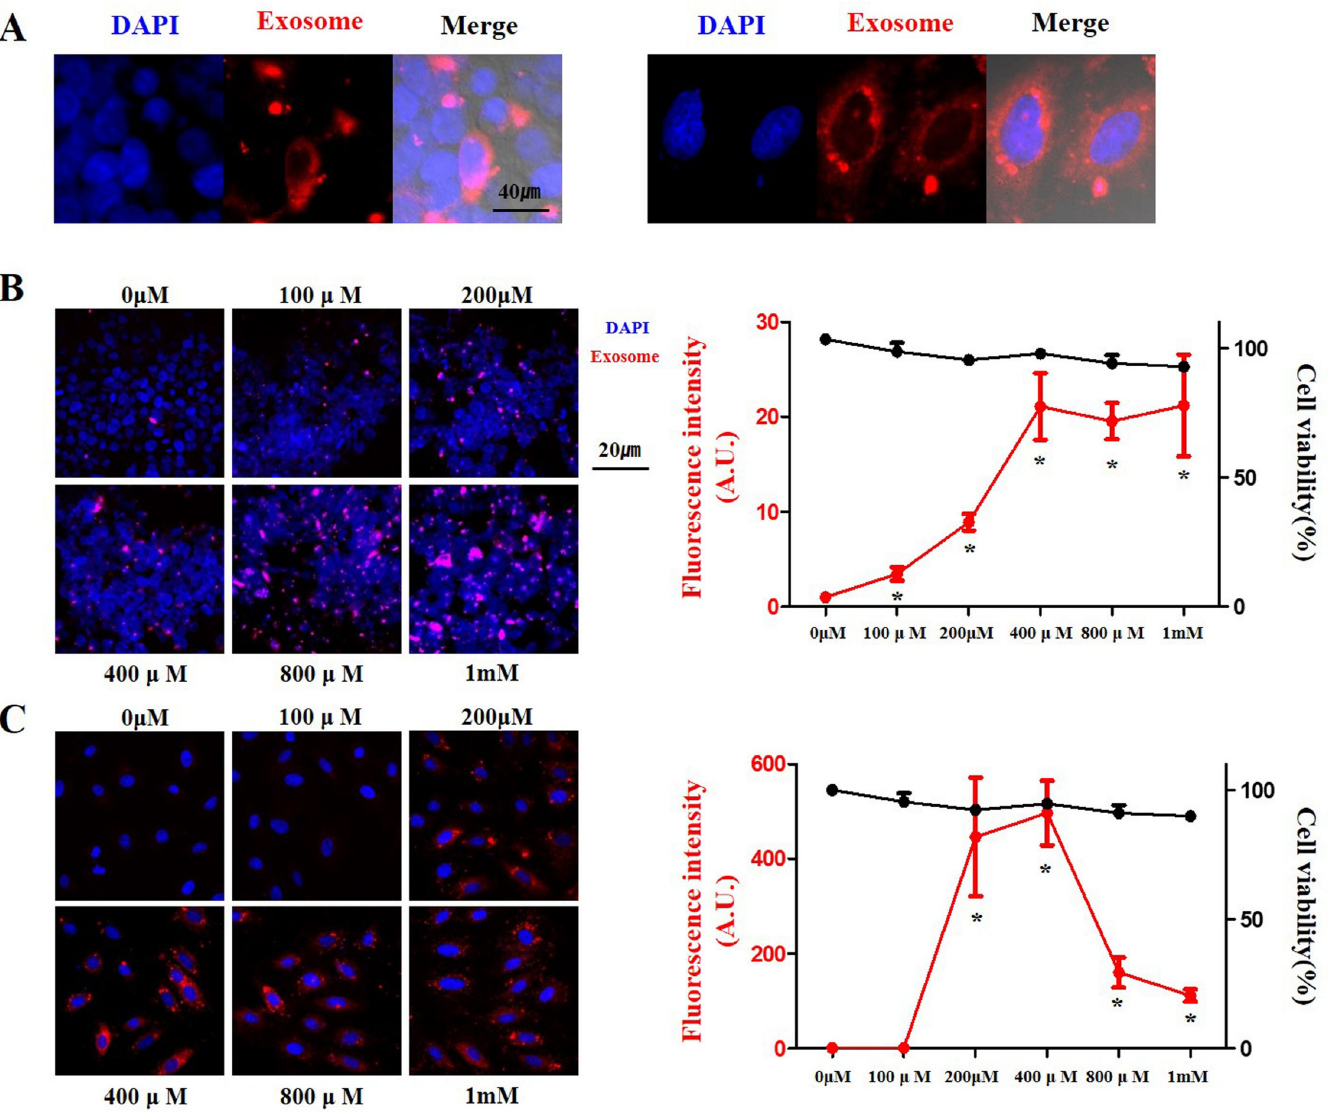
Fig 2. Delivery efficiency of exosomes with CaCl 2 in a dose-dependent manner. (A) Typical example of delivery of exosomes to HEK 293 cells (left panels) and H9C2 cells (right panels). (B) and (C) Delivery efficiency and cell viability of exosomes labeled with PKH26 (red) at different concentrations of CaCl 2 in HEK 293 (B) and H9C2 (C) cells. Fluorescent microscopic images (left panels), and fluorescence intensity and cell viability (right panels). The data are presented as the mean ± s.e.m. � P < 0.01.